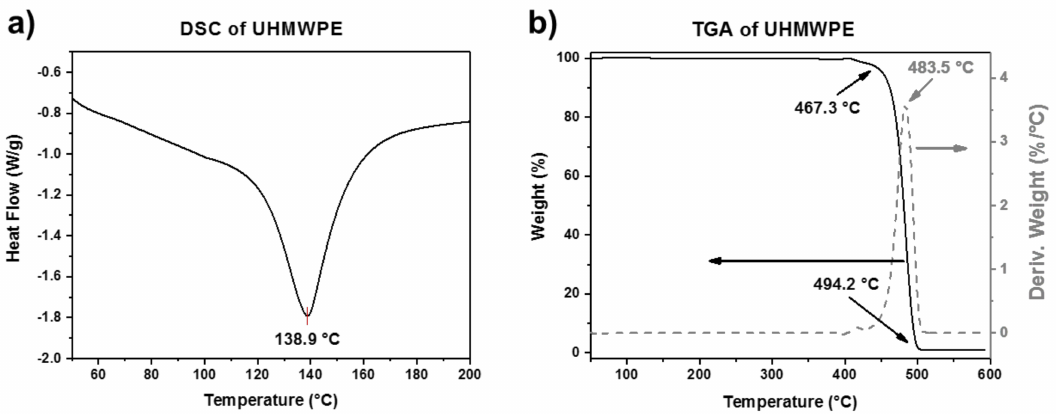
Figure 4. ( a ) DSC and ( b ) TGA plots of UHMWPE.